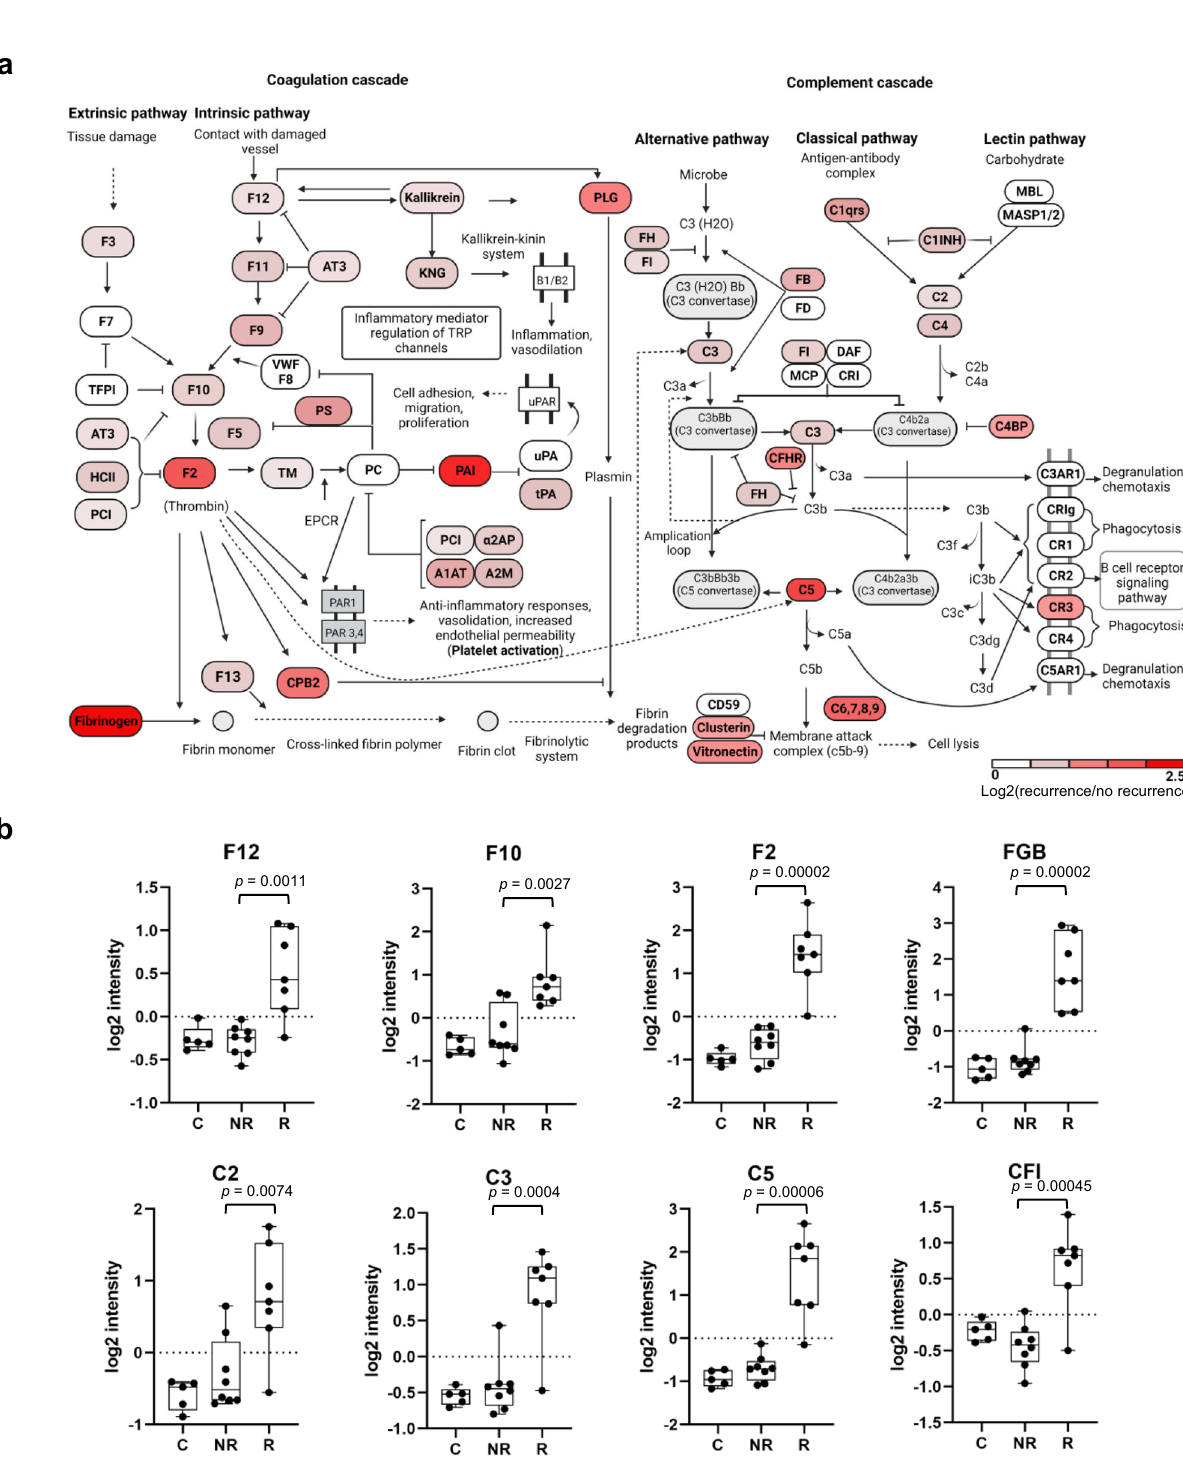
Fig. 4 The coagulation process and complement system are up-regulated in recurrent HNSCC. a The complement and coagulation cascades showing overexpression (red marked) of key pathway components in the recurrent samples. The diagram was recreated based on the KEGG pathway ID hsa04610. b Examples of coagulation or complement regulators that are signi fi cantly different between the R and NR groups. P values were based on Student ’ s t-test. The box in the box plot extends from the 25th to the 75th percentile. The whiskers go down to the smallest value and up to the largest. n = 8 for the NR group, and n = 7 for the R